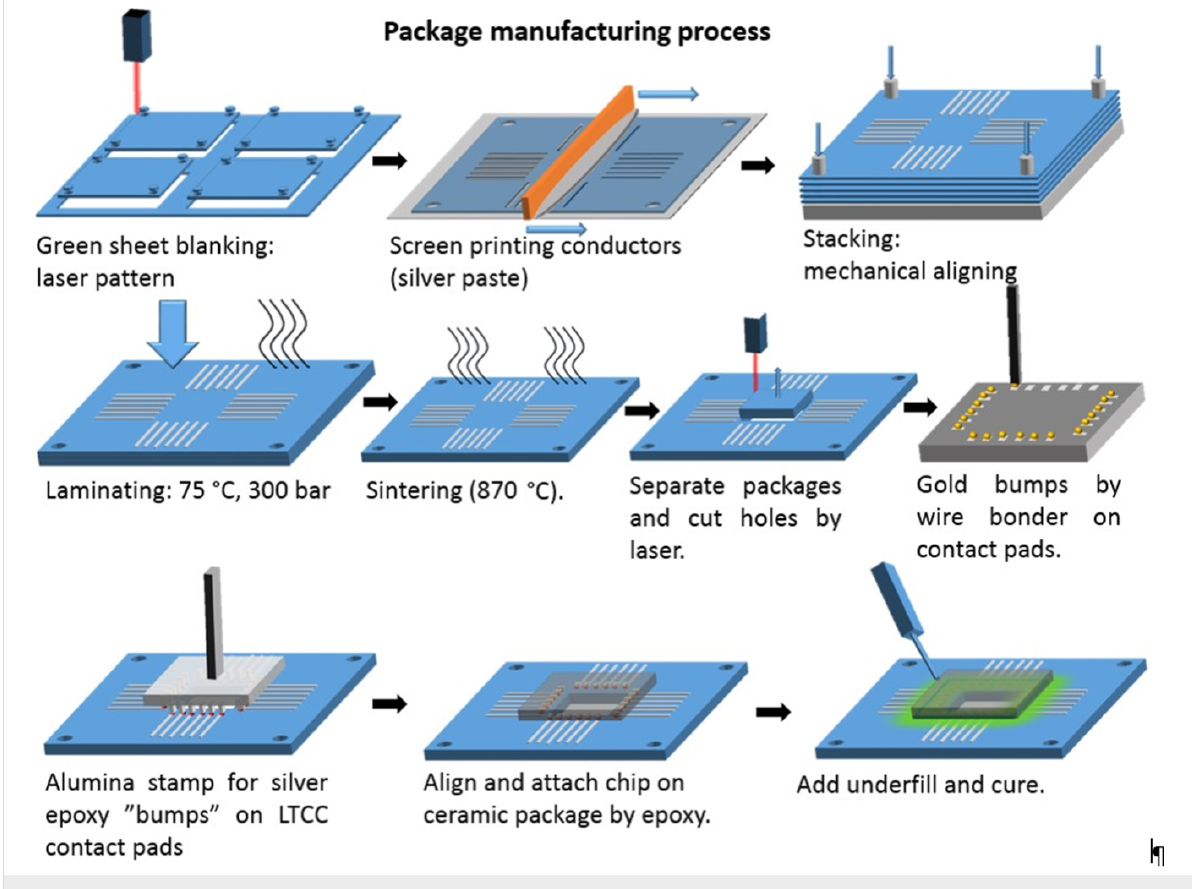
Figure 2: Schematic image of the isotropic conductive adhesive stamping process, sensor chip mounting, and underfill application.